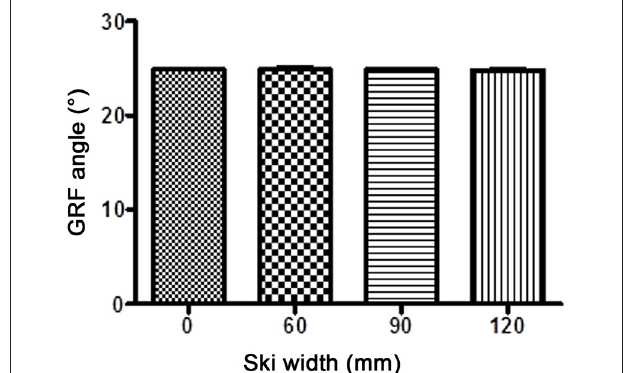
FIGURE 5 | The magnitude of the ground reaction force (GRF; mean ± SD) with different waist widths for both knee flexion settings. There were no statistical differences in GRF between different ski waist widths.